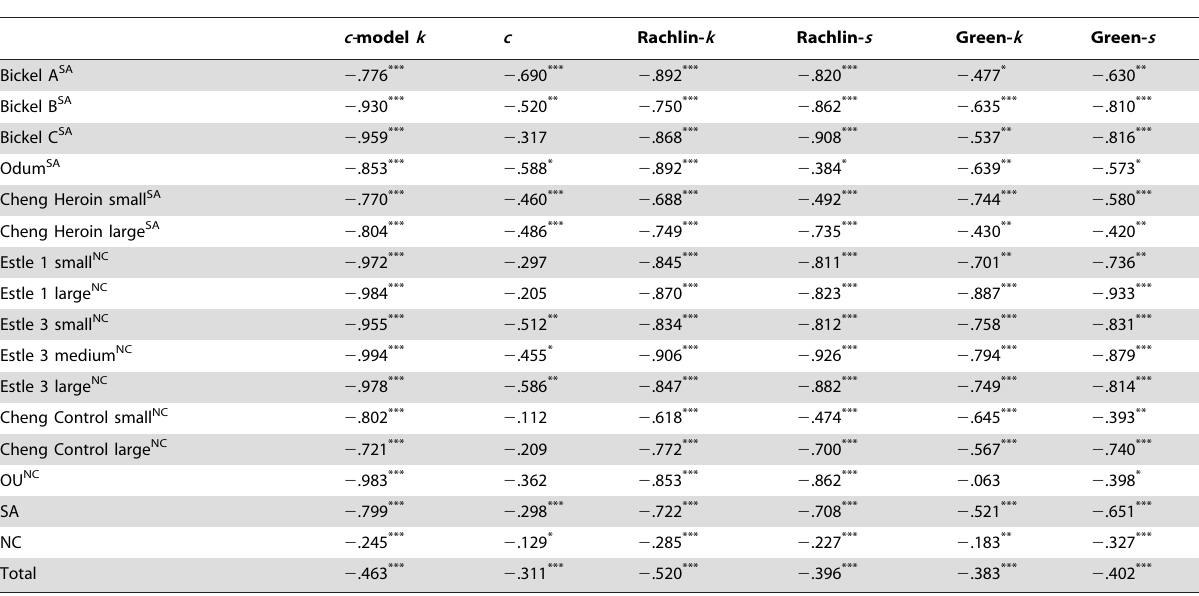
Table 10. Partial Spearman Rank Correlations Between Model Parameters and AUC.